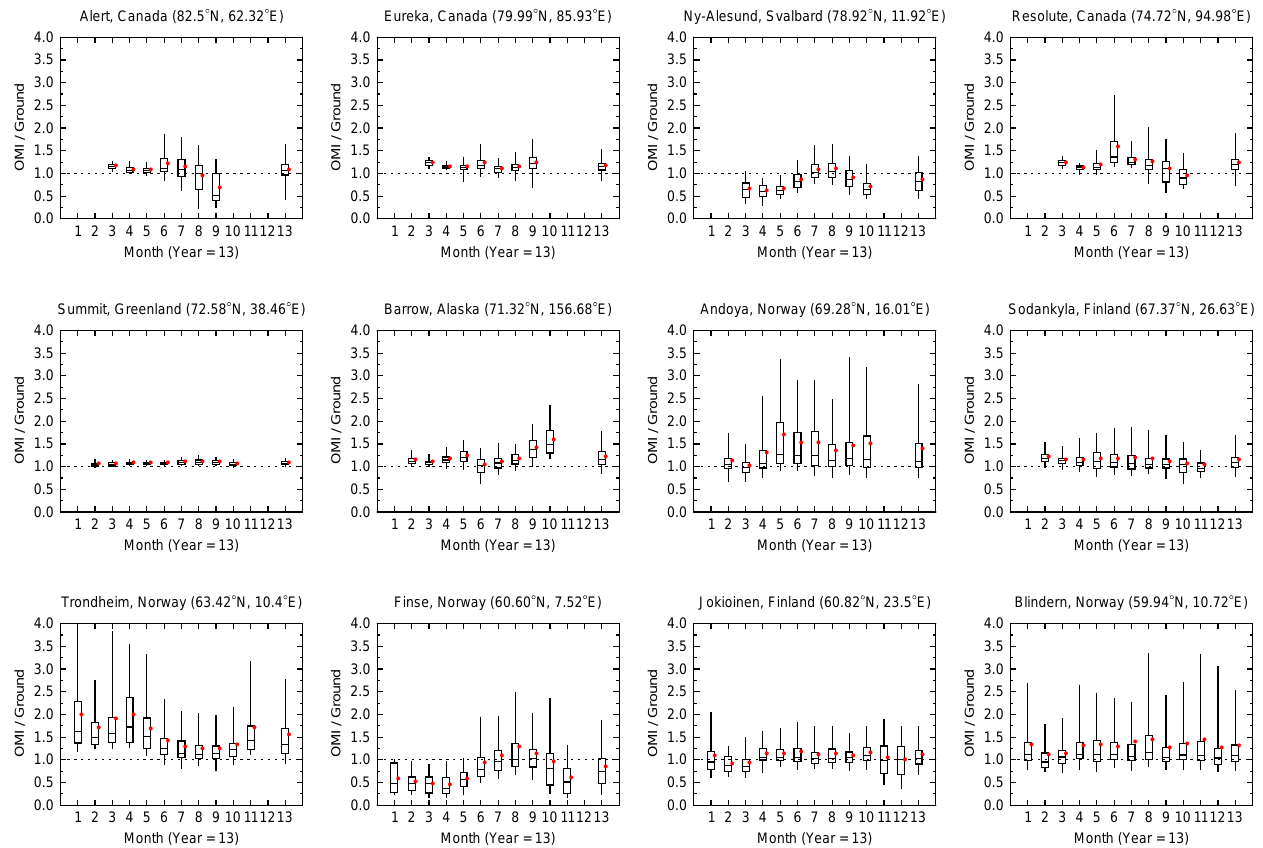
Figure 5. Same as Fig. 4 but for overpass erythemal dose rate (DP